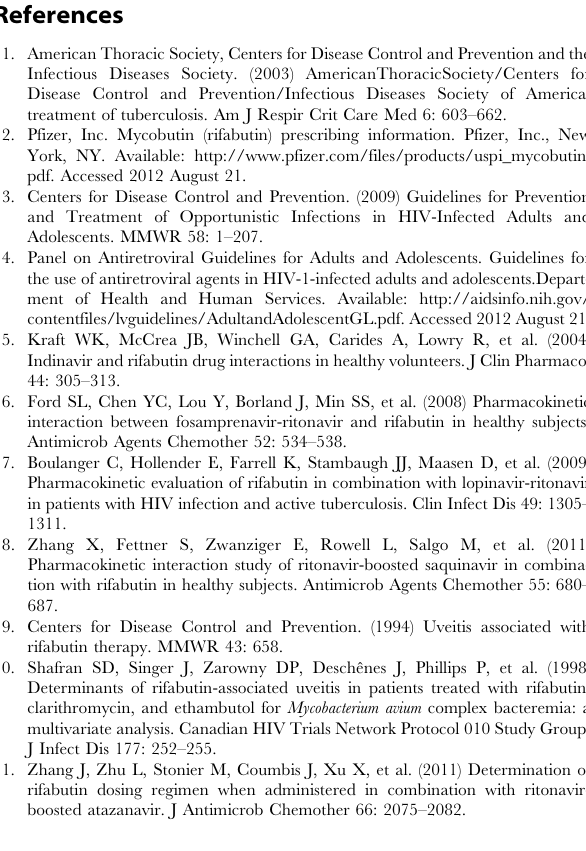
Protocol S1 Summary in English. English translation of the protocol Summary. Protocol S1 Protocol and IC form in Japanese. The full version of the study protocol and the informed consent form in